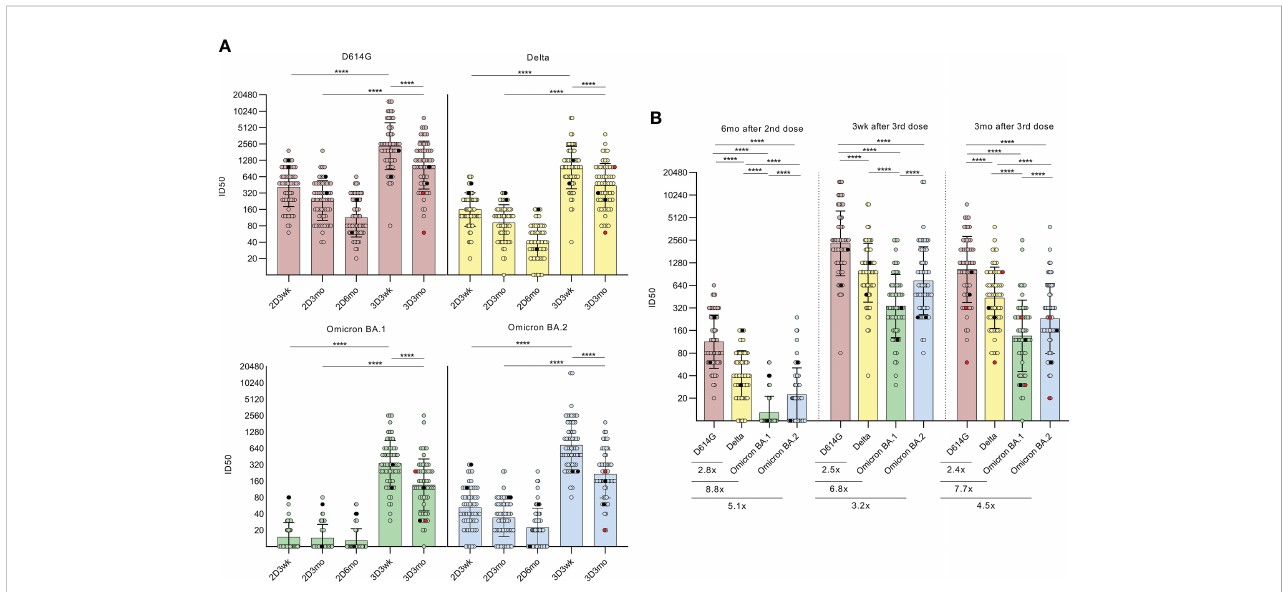
FIGURE 2 Neutralizing antibodies after the second and third COVID-19 mRNA vaccine doses. (A) , Microneutralization test was used to analyze the neutralizing antibody responses of HCWs (n=64) against D614G strain and variants Delta, BA.1, BA.2 after the second vaccine dose at three-week (2D3wk, n=60, BA.2 n=59), three-month (2D3mo, n=60, BA.2 n=59) and six-month (2D6mo, n=62, BA.2 n=61) time points as well as after the third vaccine dose at three- week (3D3wk, n=63, BA.2 n=62) and three-month (3D3mo, n=59, BA.2 n=58) time points. HCWs with PCR-con fi rmed SARS-CoV-2 infection prior to the fi rst vaccination (n=2) are marked with black dots and breakthrough infections after the third dose (n=2) are marked with red dots. Differences between time points (2D3wk vs 3D3wk; 2D3mo vs 3D3mo; 3D3wk vs 3D3mo) were analyzed with Wilcoxon signed-rank test. (B) , Neutralization titers between D614G strain and variants Delta, BA.1, and BA.2 at six months after the second vaccine dose as well as three weeks and three months after the third vaccine dose were compared and are represented as fold differences below the fi gures. Wilcoxon signed-rank test was used to analyze the statistical signi fi cance, and two-tailed p-values <0.05 were considered statistically signi fi cant. Samples with no data on both data points were excluded from the analyses. The geometric means with geometric SDs are shown in the fi gures.